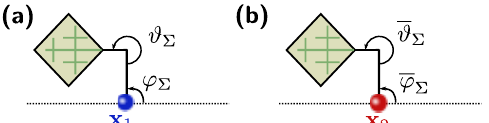
Figure 5: The orientations of the first two string segments starting from hole 1 in (a) (hole 2 in (b)) are labeled by the angle ϕ Σ ( ϕ Σ ) relative to the x -axis, and the angle ϑ ϑ Σ ( Σ ) measured relative to the preceding string